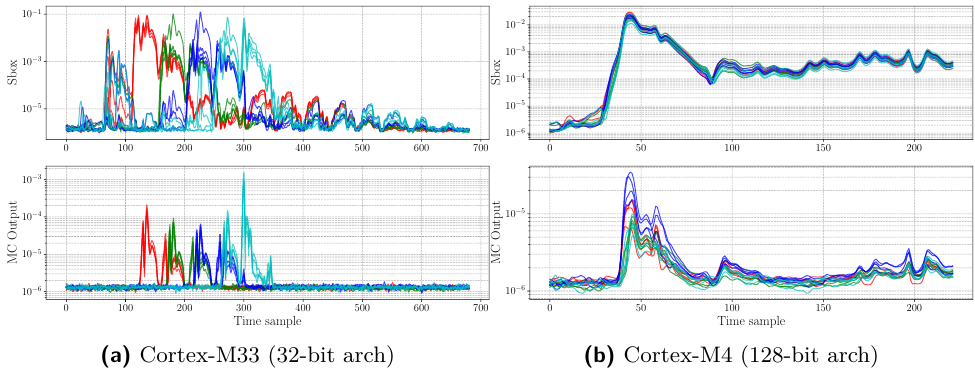
Figure 3: SNR on AES S-boxes and MixColumns outputs evaluated on 200 · 10 6 traces. The color mapping corresponds to bytes within the same AES